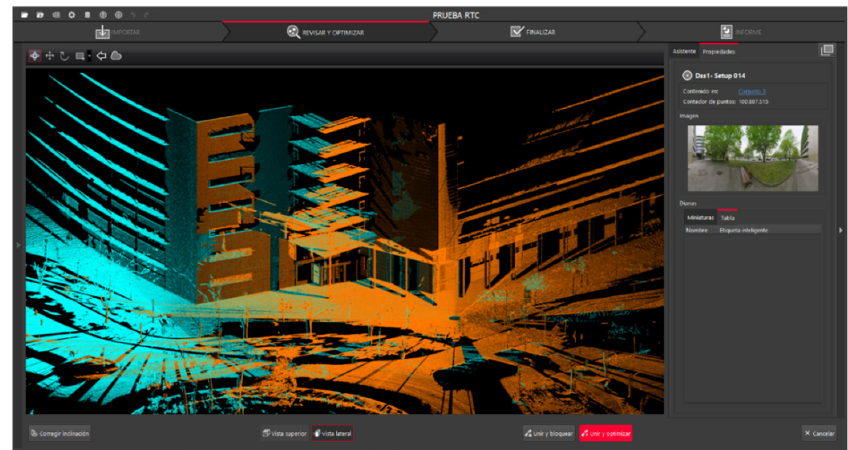
Figure 8. Editing and optimization of point clouds “cloud-to-cloud”, using Cyclone software. DSS Campus, Zone 2.